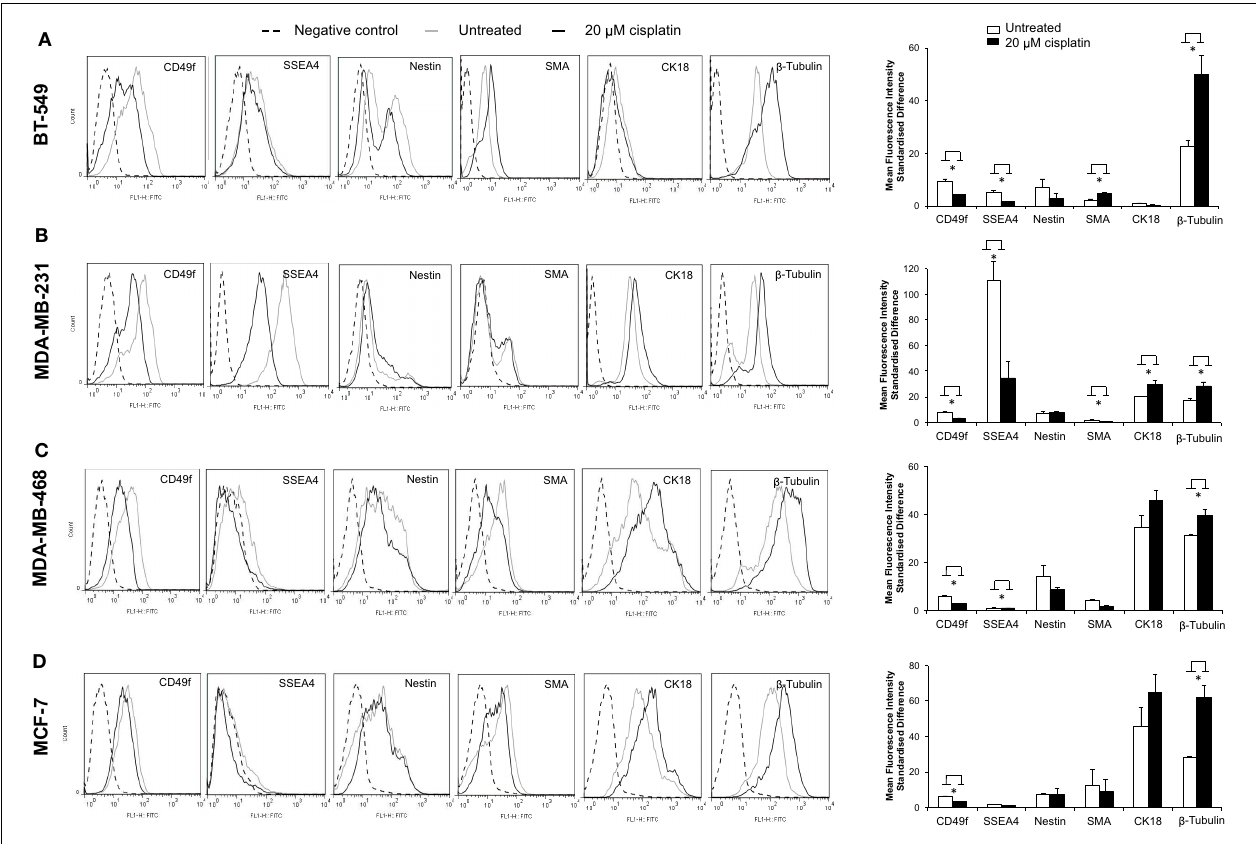
FITC-stained 20 µ M cisplatin-treated breast cancer cells).The bar charts show quantification of the level of expression based on the mean fluorescence intensity (MFI) standardized difference of cisplatin-treated (20 µ M cisplatin for 24h) and untreated BT-549, MDA-MB-231, MDA-MD-468, and MCF-7 breast cancer cells. Bars are presented as mean fluorescence intensity (MFI) standardized difference ± SEM ( n = 3). * p ≤